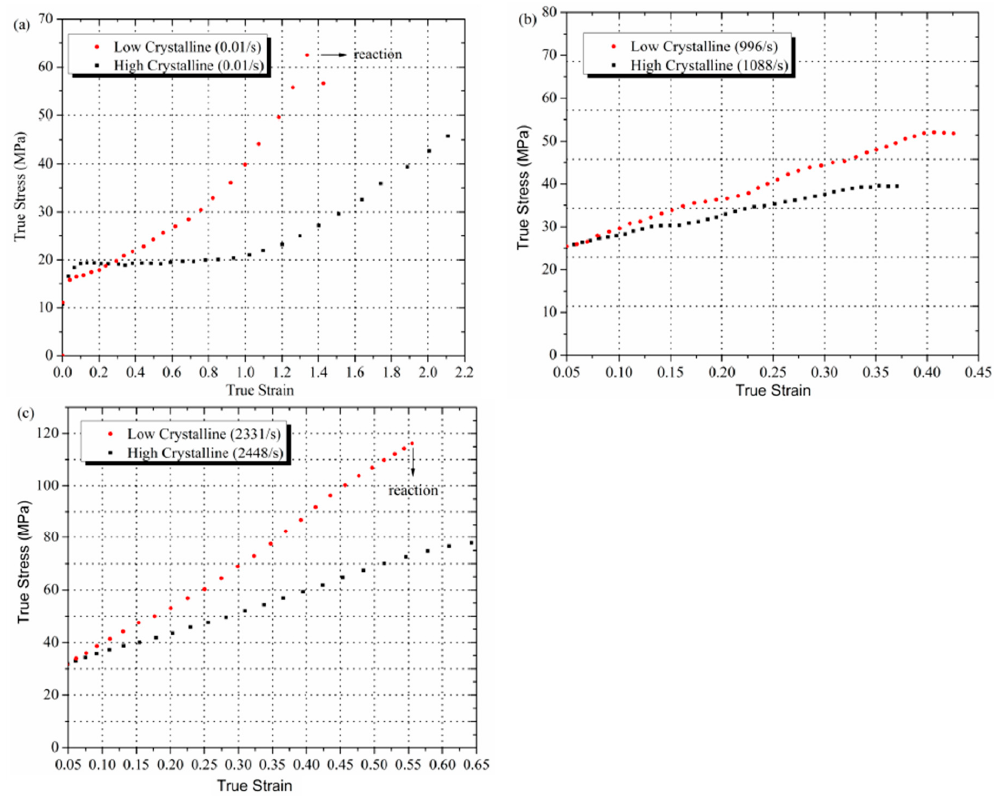
Figure 6. Comparison of stress-strain curves between low crystalline and high crystalline Al-PTFE at ( a ) strain rate of 0.01 s − 1 ; ( b ) strain rate of about 1000 s − 1 ; and ( c ) strain rate of about 2300 s − 1 . The point where the reaction took place is marked.